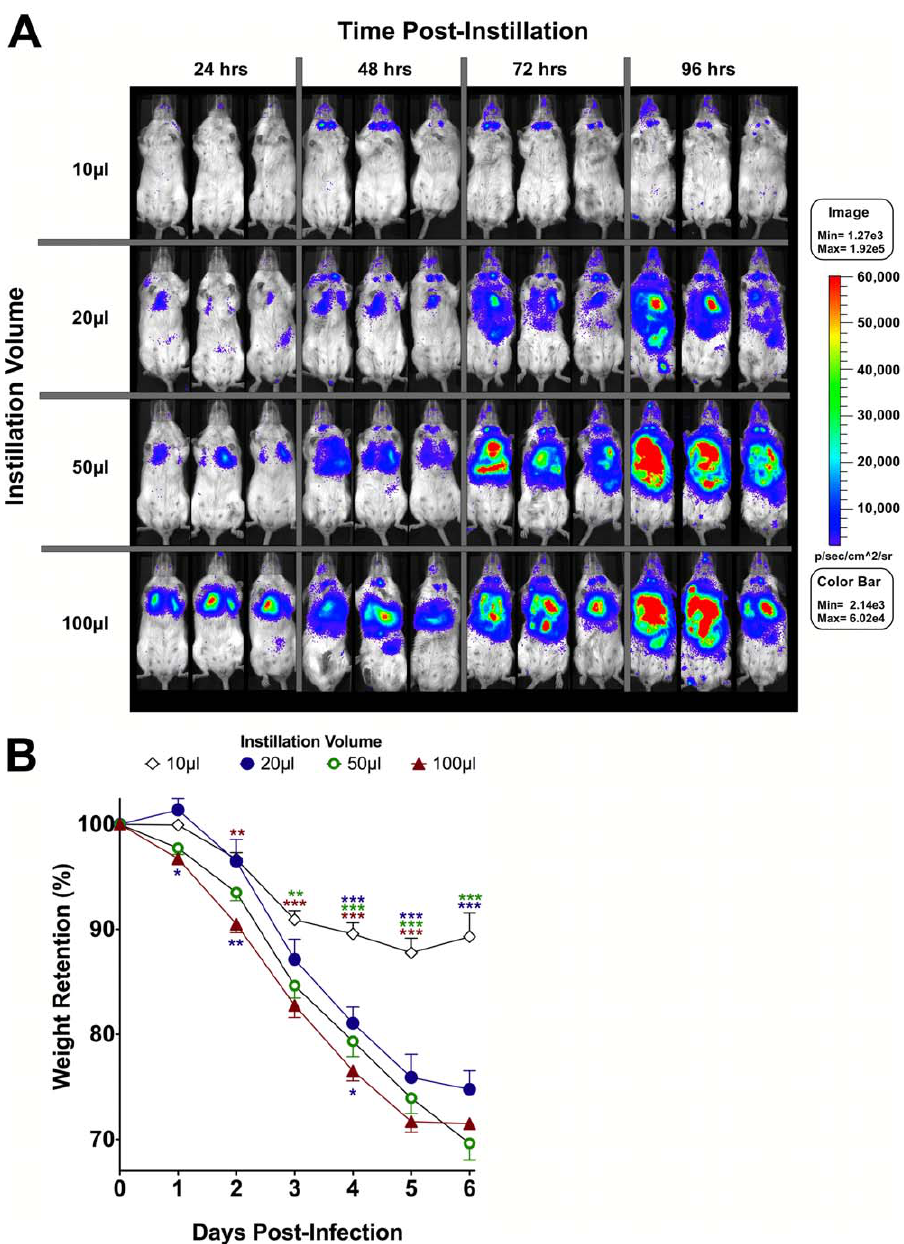
Figure 3. Kinetic invivo localization of luminescent FTLVS following intranasal dosing in titrated volumes of inocula. BALB/c mice (3/ group) were challenged via the intranasal route with 1 6 10 6 CFU of FTLVS-lux suspended in a volume of 10 m l, 20 m l, 50 m l, or 100 m l of sterile PBS. Panel A : All mice were then subjected to whole animal imaging using an IVIS Spectrum Imaging system at the indicated time points. Scaling intensity of all images was normalized and data are reported as photons/sec/cm ‘ 2/sr. Panel B : All mice were weighed daily as a measure of disease- state. Statistical analysis was performed via 2-way ANOVA with Bonferroni post-tests. Significant differences between the 10 m l instillation volume group and all other groups are indicated toward the top of the graph and are color-coded. Significant differences between the 100 m l instillation volume group and either the 20 m l or 50 m l dose volume groups are indicated toward the bottom of the graph and are color-coded. The calculated p values are indicated as follows: p , 0.05 (*), p , 0.01 (**), and p , 0.001